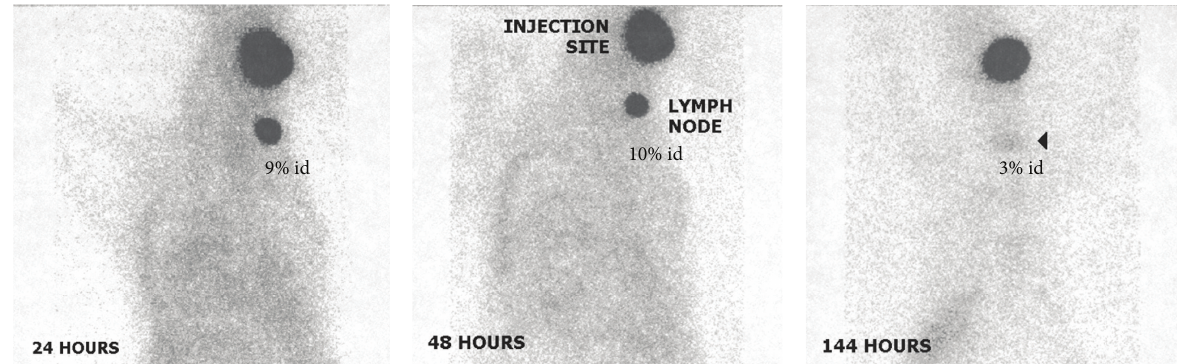
Figure 3: Anterior static images of a sheep taken at 24, 48, and 144 hours after a subcutaneously injected dose (id) of 111 In-dendritic cells in the neck and migration to the nearest lymph node ( 󳶣